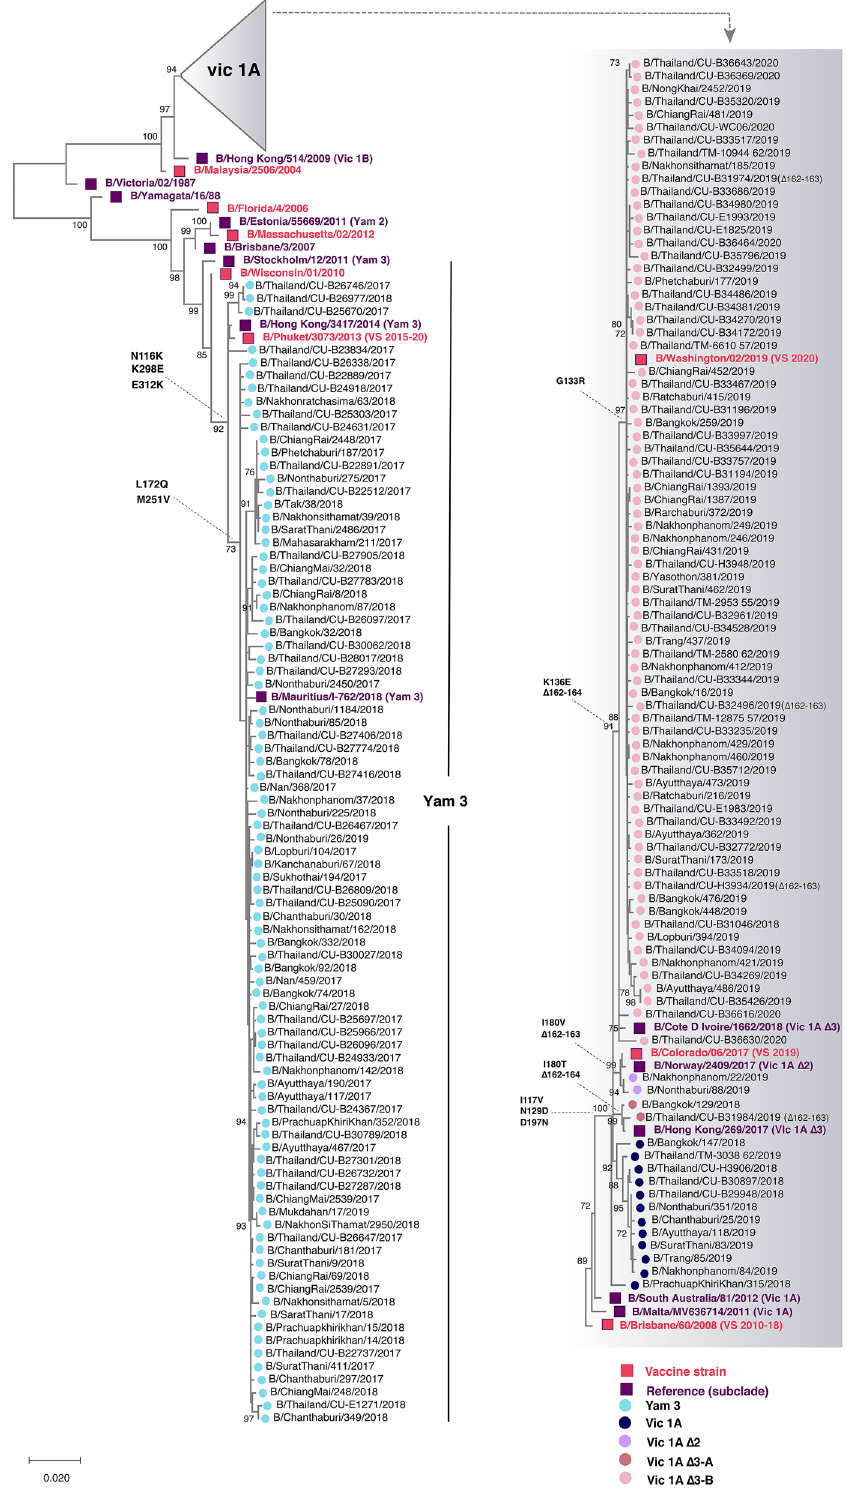
Figure 4. Phylogenetic analyses of the nucleotide sequences of the HA coding region of the influenza B virus. Eighty-one nucleotide sequences from this study (designated A/Thailand/CU) and other Thai strains available from the database during July 2017-March 2020 (n = 96) were compared with the influenza B vaccine and reference strains of known clades (magenta and purple squared, respectively). Phylogenetic tree was constructed using the maximum-likelihood method and the HKY + G model with 1000 bootstrap replicates implemented in MEGAX. Branch values of > 70% are indicated at nodes. Colored circles denote the clade and subclade of the circulating influenza B virus strains. VS defined as vaccine